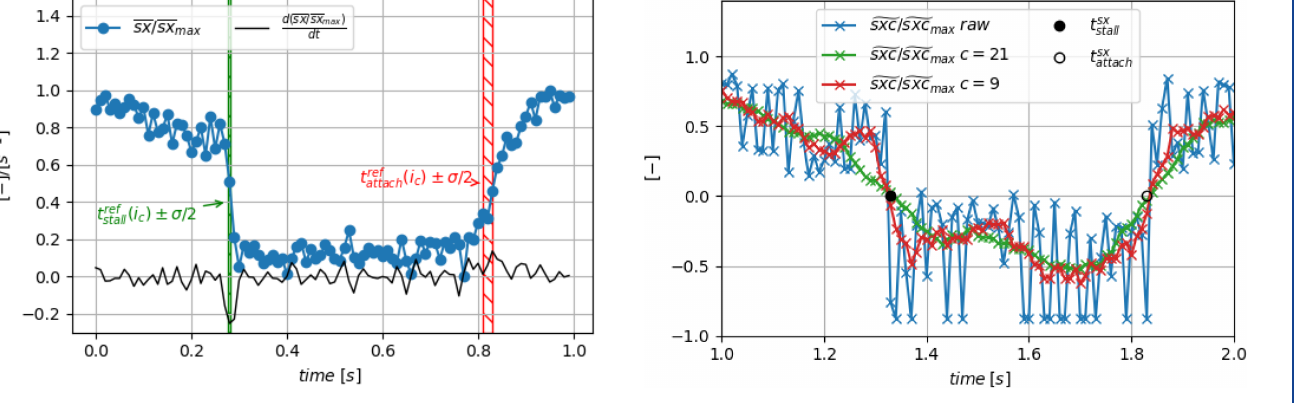
Figure 21. The evolution of dimensionless phase-averaged stream- Figure 23. Zoom on a period of the corrected signal (cid:102) sxc( t ) (varia- wise coordinate of the center of the strip, sx / sx max , during the os- tions in sxc( t )) with the detected instants and the smoothed signal cillation cycle (blue dotted line) together with its time derivative superimposed using two filter sizes c = 9 and c = (black line). The time window width marked by the red hatched area corresponds to the standard deviation σ ( t ref ( i c ) − i c .T ) cen- stall ( i c ). The time window width marked by tered on the averaged t ref stall the green hatched area corresponds to the standard deviation value σ ( t ref ( i c ) − i c .T ) centered on the phase-averaged t ref ( i c ) . attach attach